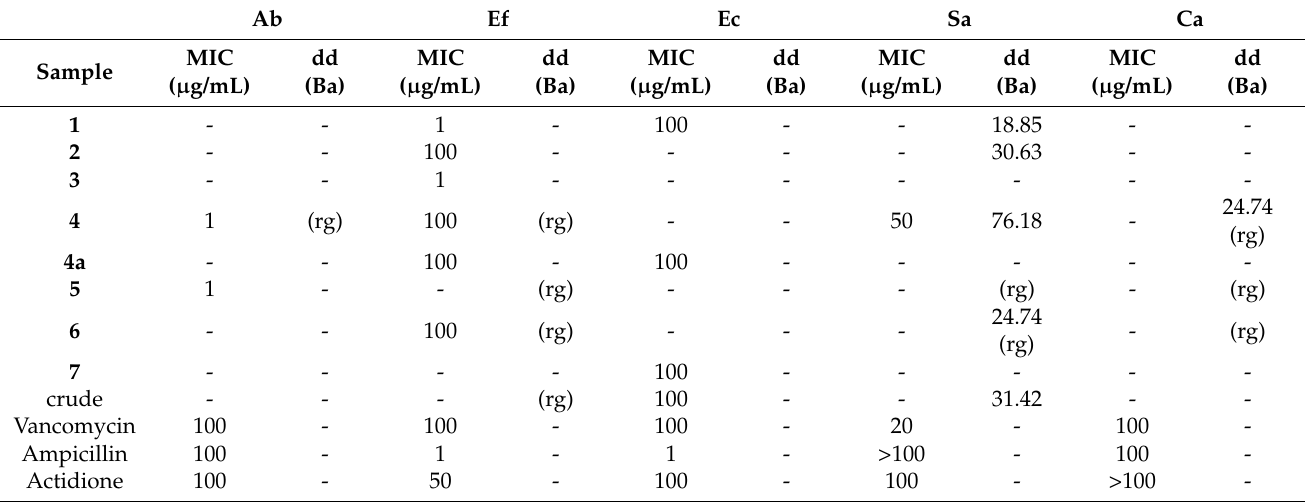
Table 4. Antimicrobial data for the crude extract and the compounds isolated. MIC values are given in µ g/mL, while the disk diffusion (in mm 2 ) and bioautography results are also shown. Ab